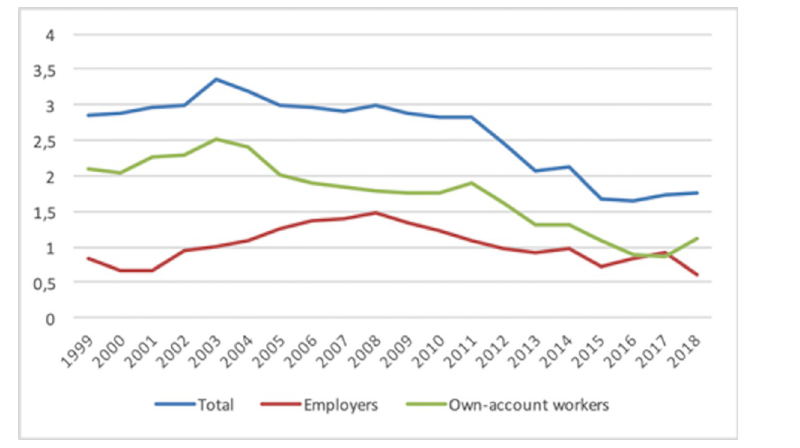
Fig 2. Native vs. foreign-born self-employment rate differences. 1999–2018. Country average.